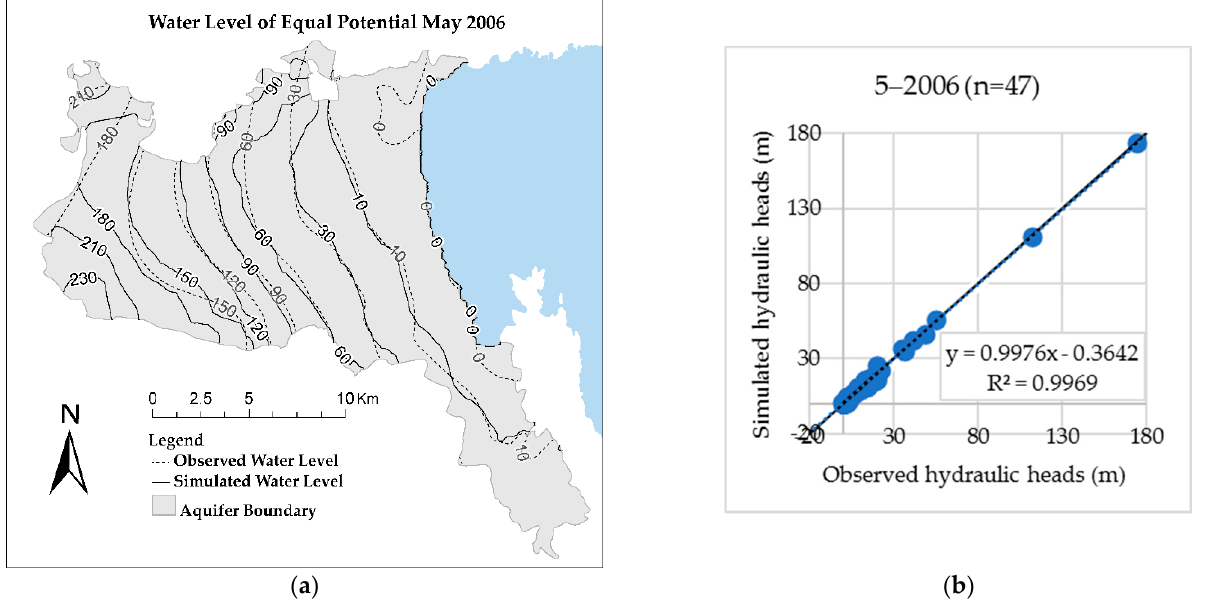
Figure 10. ( a ) The water level of equal potential for May 2006 and ( b ) scatterplot of simulated against observed water table values.